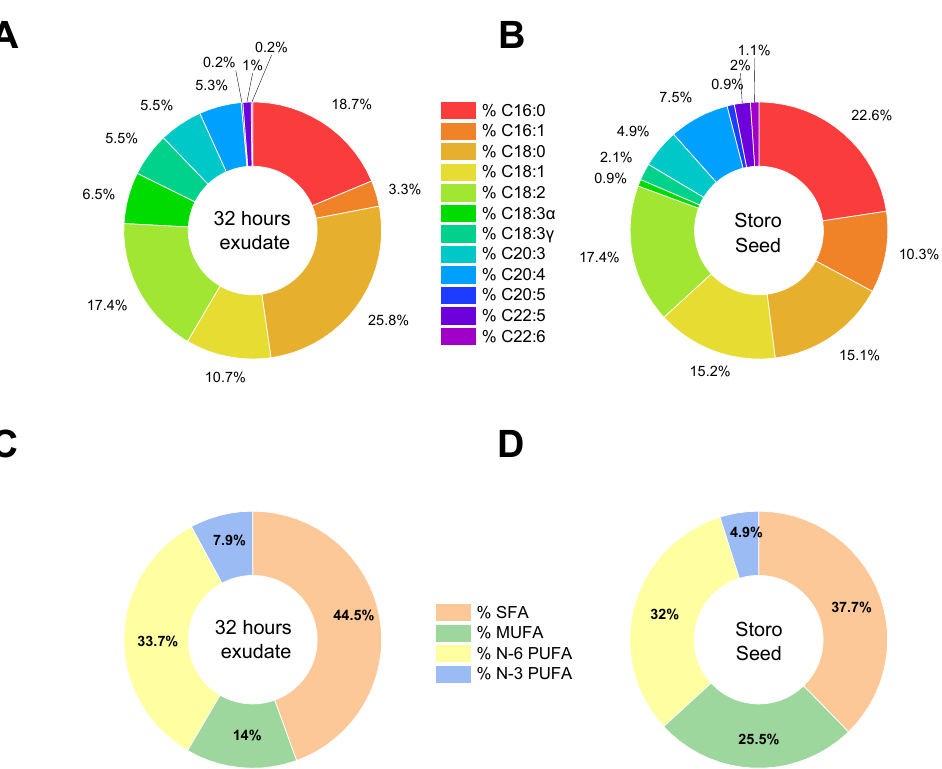
Figure 4. Methyl esters fatty acids (FAME) on 32 h Nostrano di Storo seed imbibition medium ( A , C ) and on ungerminated Nostrano di Storo seeds ( B , D ). Panel A and B report the relative proportion of the identified FAME, while panels C and D group FAME according to the saturation of the aliphatic chains as Saturated Fatty Acids (SFA); Monounsaturated Fatty Acids (MUFA); ω-6 Polyunsaturated Fatty Acids (N-6 PUFA); ω-3 Poly Unsaturated Fatty Acids (N-3 PUFA).